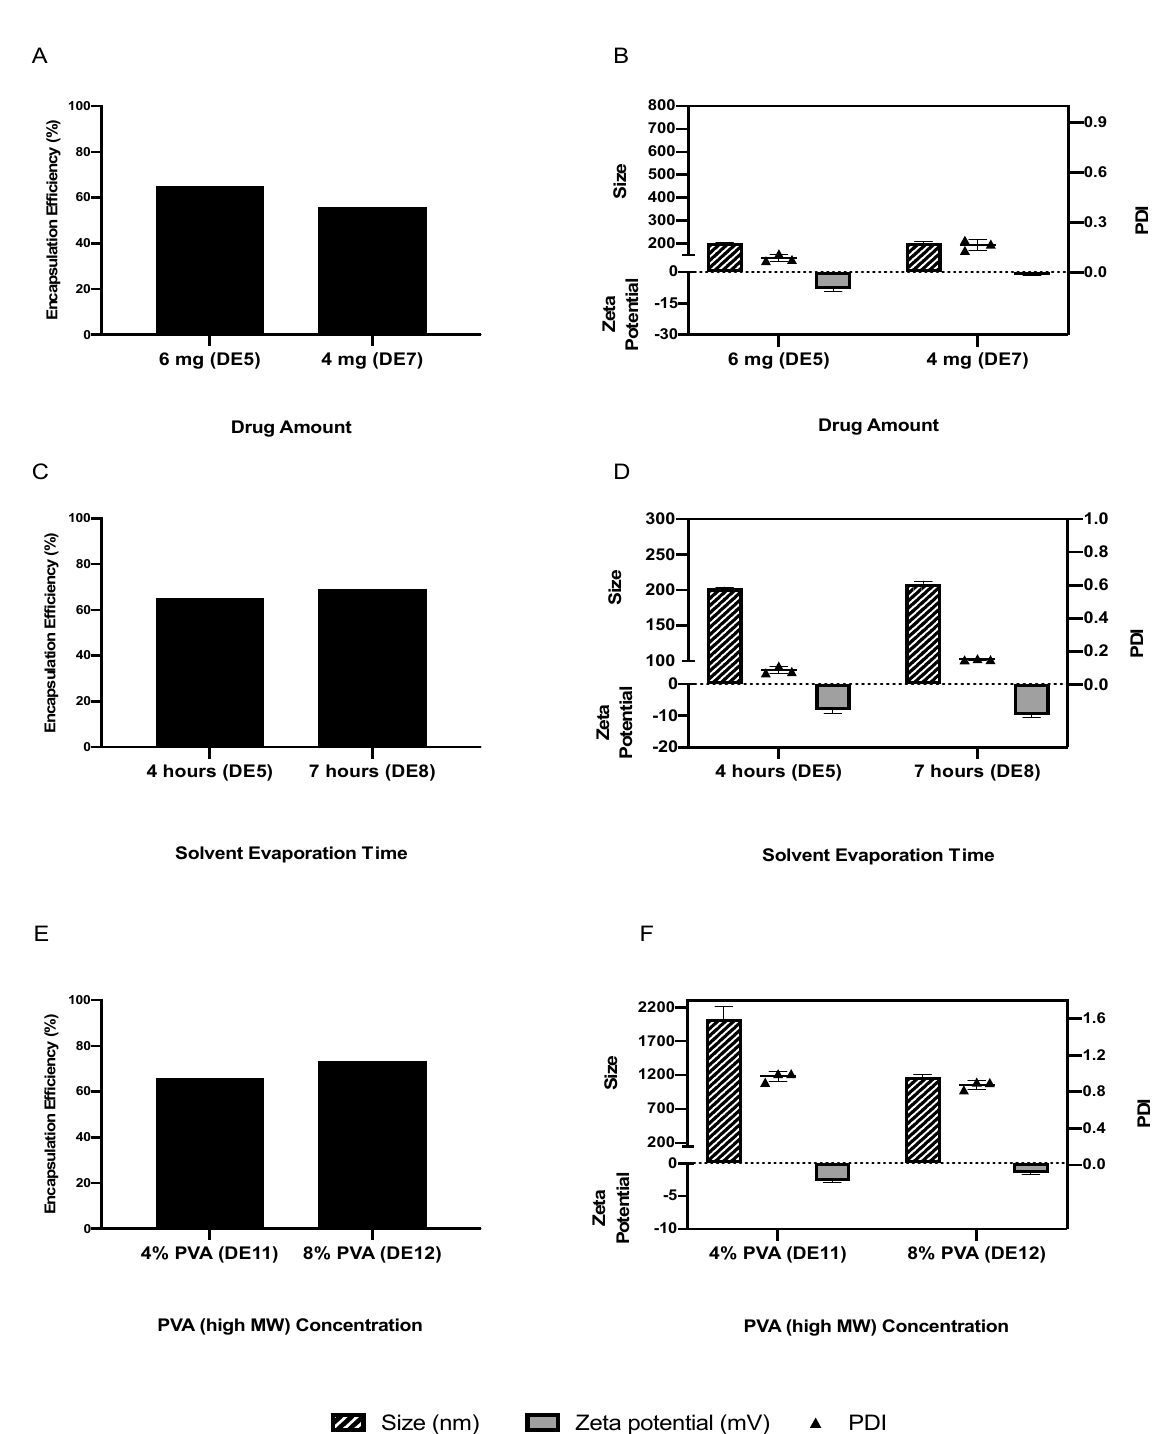
Figure 4. The impact of drug amount ( A , B ), solvent evaporation time ( C , D ) and high-MW PVA ( E , F ) on the average particle size, PDI, zeta potential and EE of optimized nanoparticles manufactured using the double emulsion technique.